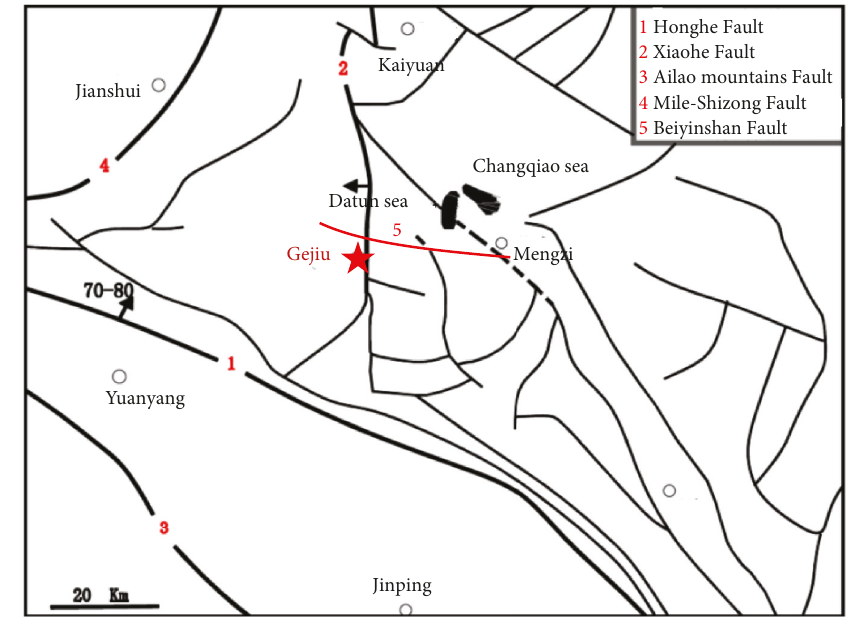
Figure 2: Simplified structural map of the study